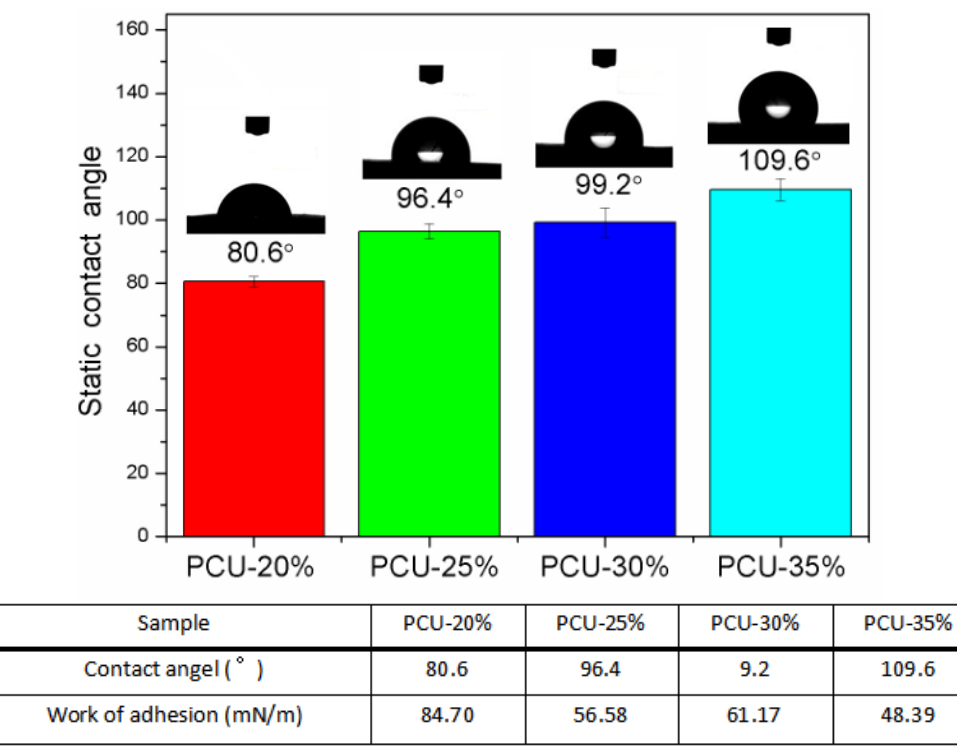
Figure 4. Surface contact angles of the different contents of hard segments of the polyurethanes.